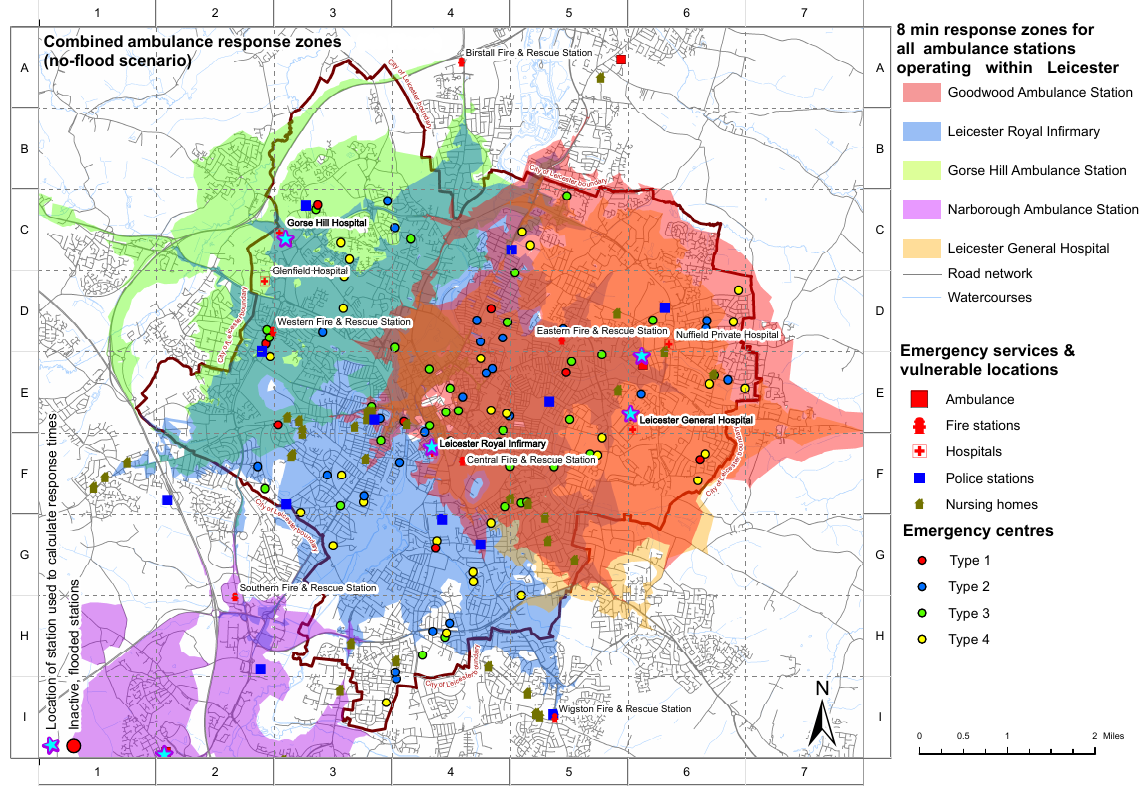
Figure 7. Accessibility of the city (8min) for ambulance service stations operating under normal no-flood conditions. Table 1. Percentage of area accessible to fire and rescue and ambulance service stations under normal and flood scenarios. Flood